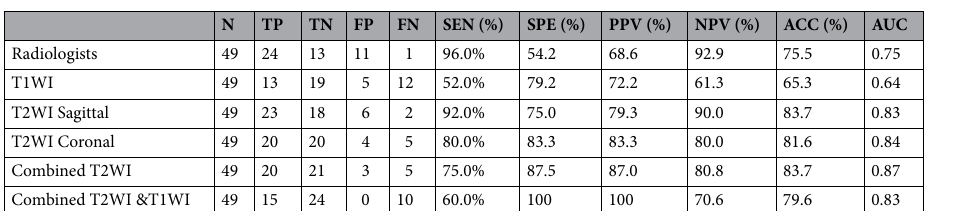
Table 3. Diagnostic performance comparison between two experienced radiologists and computer in ovarian masses discrimination in the testing group at reference standard in the patient-based evaluation based on MR imaging. TP = true positive, TN = true negative, FP = false positive, FN = false negative, N = TP + TN + FP + FN.